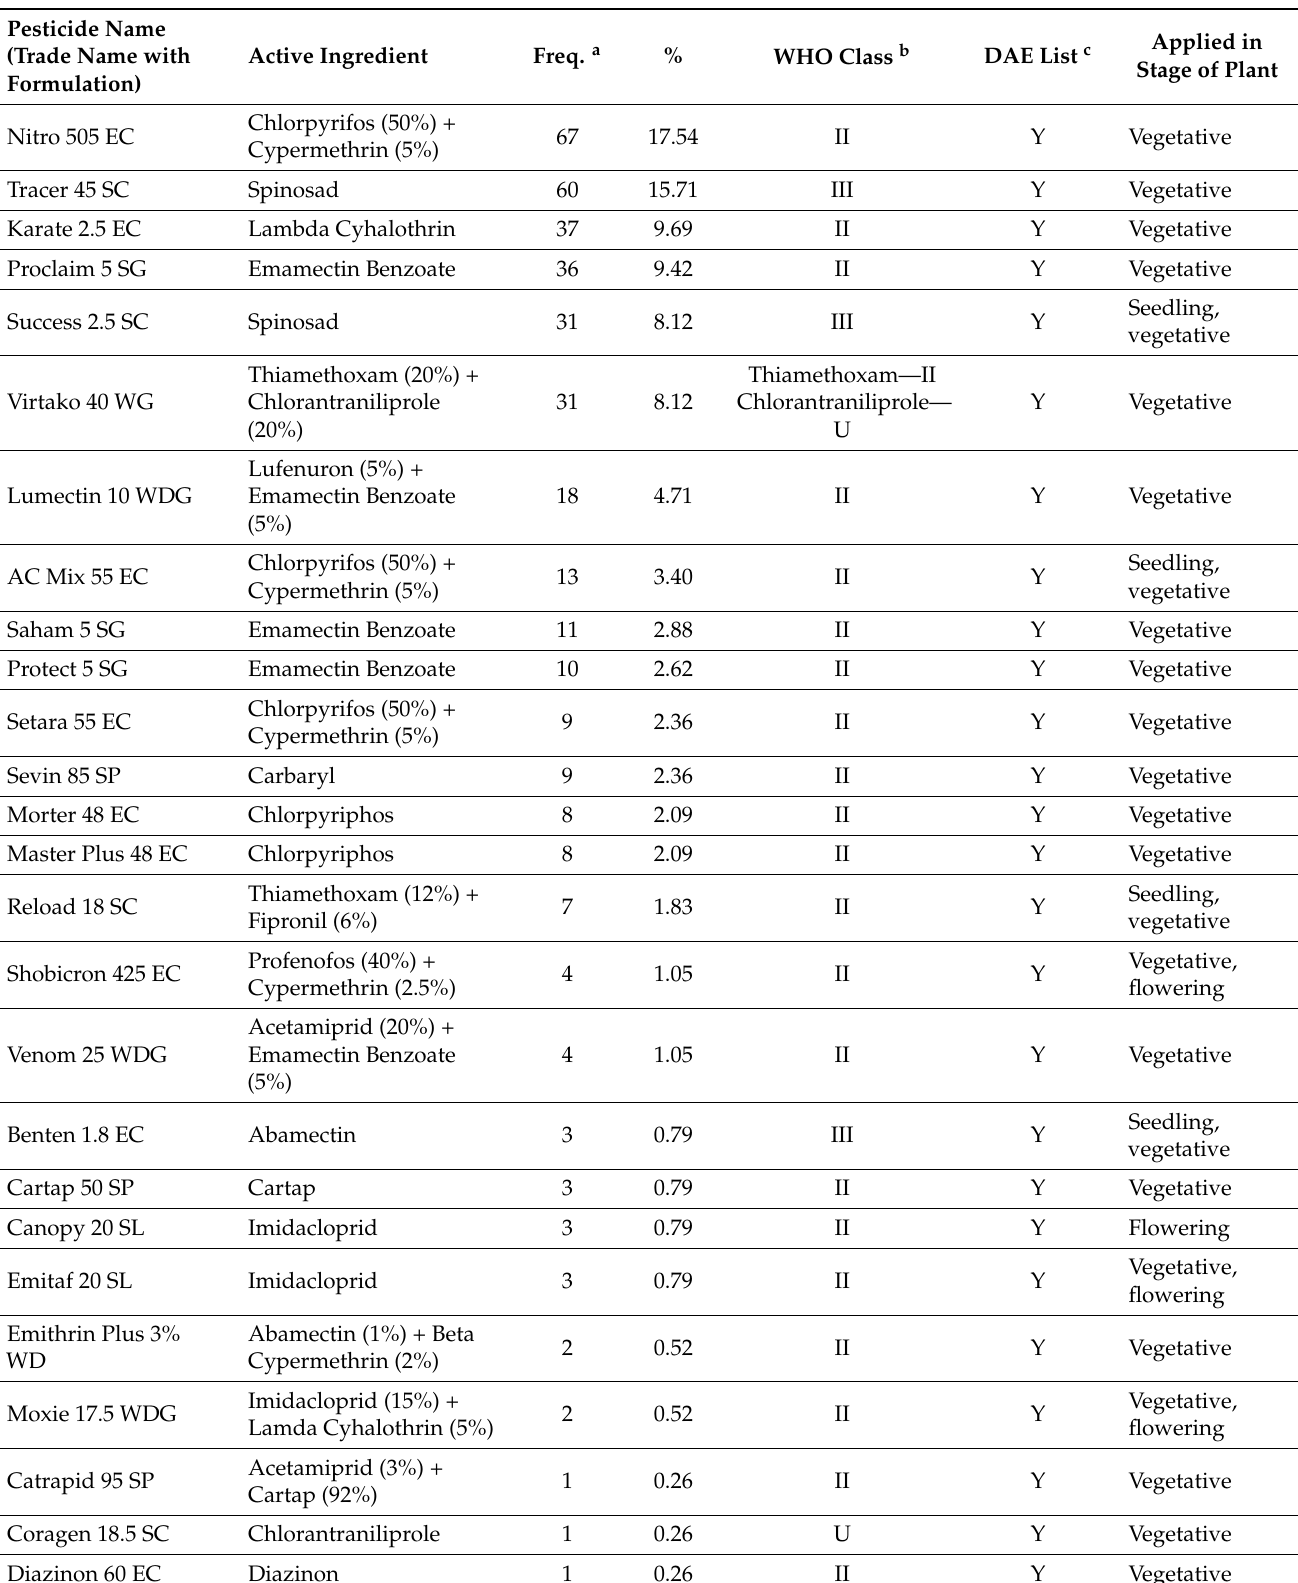
Table 4. Pesticides used by farmers for fall armyworm control and their